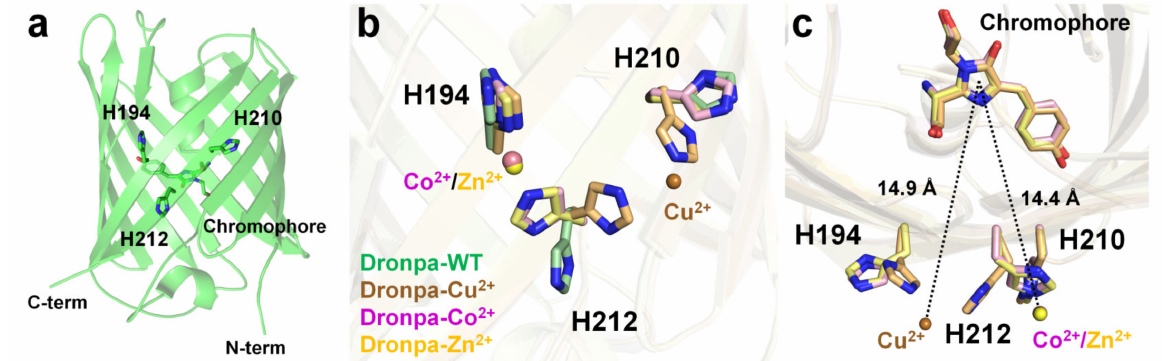
Figure 6. Crystal structure of native (PDB code 2GX2) and the Cu 2+ - (5HZT), Co 2+ -(5HZS), and Zn 2+ (5HZU)-bound-state of Dronpa. ( a ) Dronpa contains three native histidine residues (H194, H210, and H212) on the β -can as the metal-binding site. ( b ) Comparison of the metal-binding site and the conformational change of histidine residues in Dronpa. ( c ) Measurement of distance between the metal ion and the chromophore of